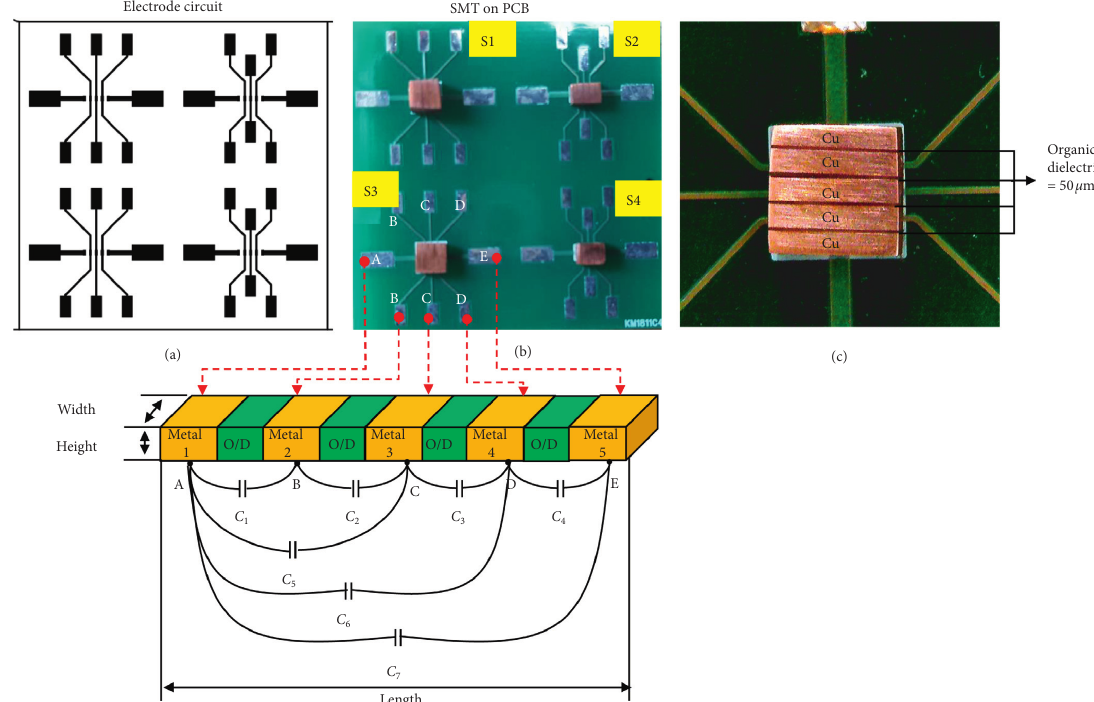
Figure 5: SMT of array capacitors on the PCB to measure the electrical